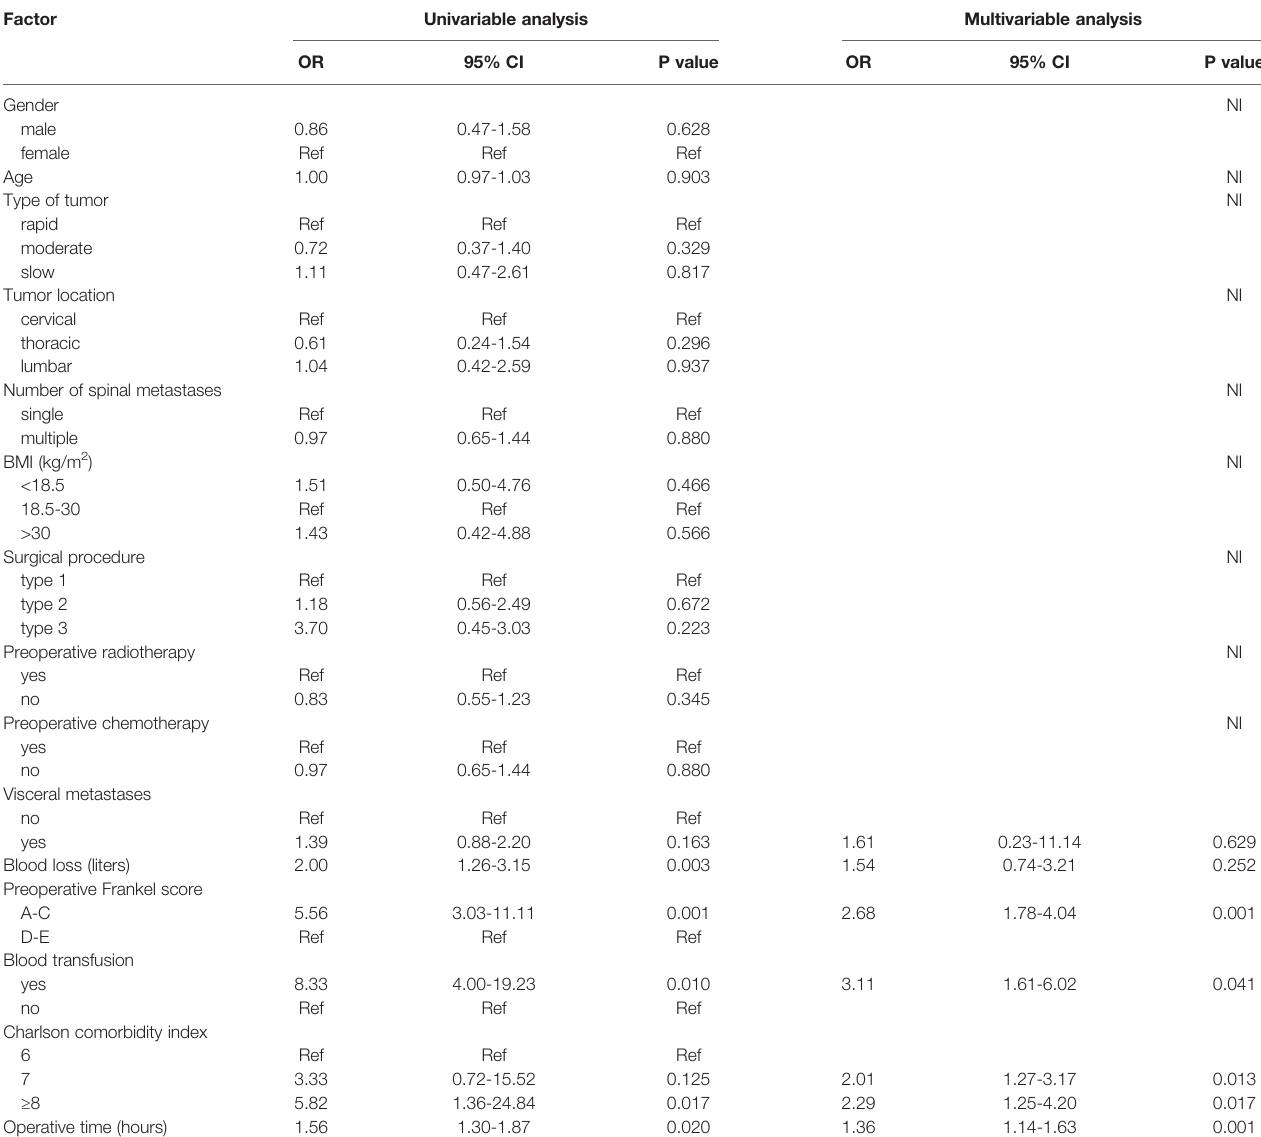
TABLE 2 | Logistic regression assessing risk factors for venous thromboembolism.